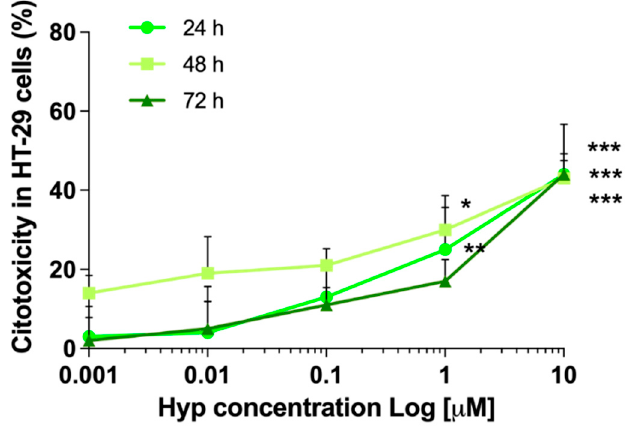
Figure 1 . Hypericin cytotoxicity in HT-29 2D cells. Cytotoxicity curves in HT-29 2D cell cultures were obtained by incubating cells with increasing concentrations of Hyp (0.001, 0.01, 0.1, 1, and 10 μ M). WST-1 assay was carried out to evaluate Hyp cytotoxicity that was expressed as a percentage compared with untreated cells after 24, 48, and 72 h of incubation. Statistically significant difference versus untreated cells: * p ≤ 0.05, ** p ≤ 0.01, and *** p ≤ 0.001 ( n = 2).